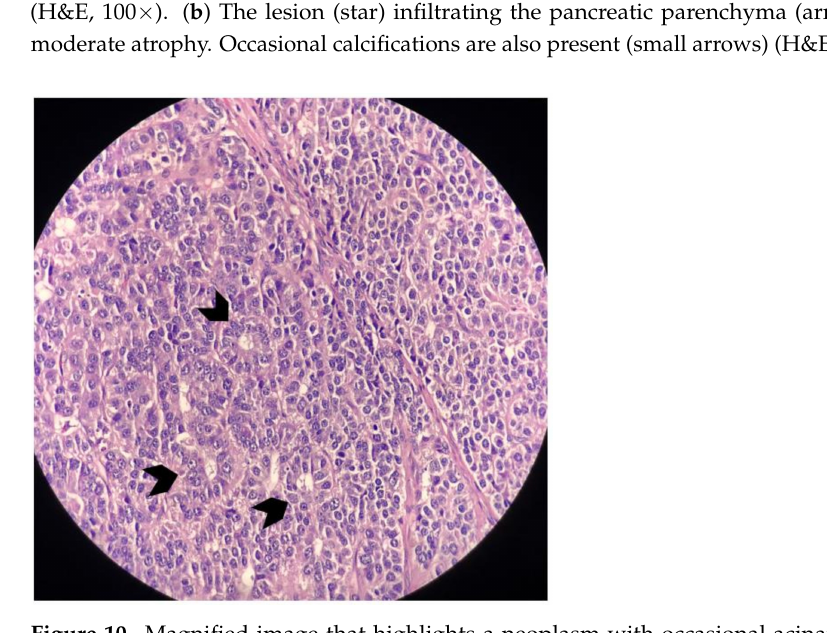
Figure 10. Magnified image that highlights a neoplasm with occasional acinar formation (small arrows) (H&E, 400 ×